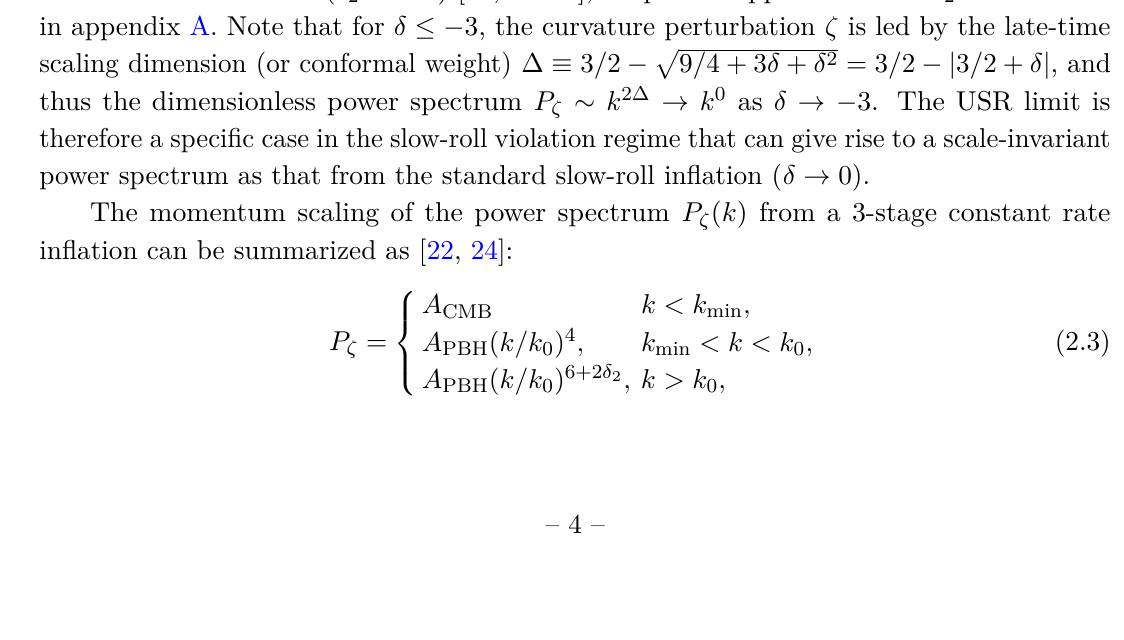
= 0 of the primary slow-roll and Phase 2 δ 1